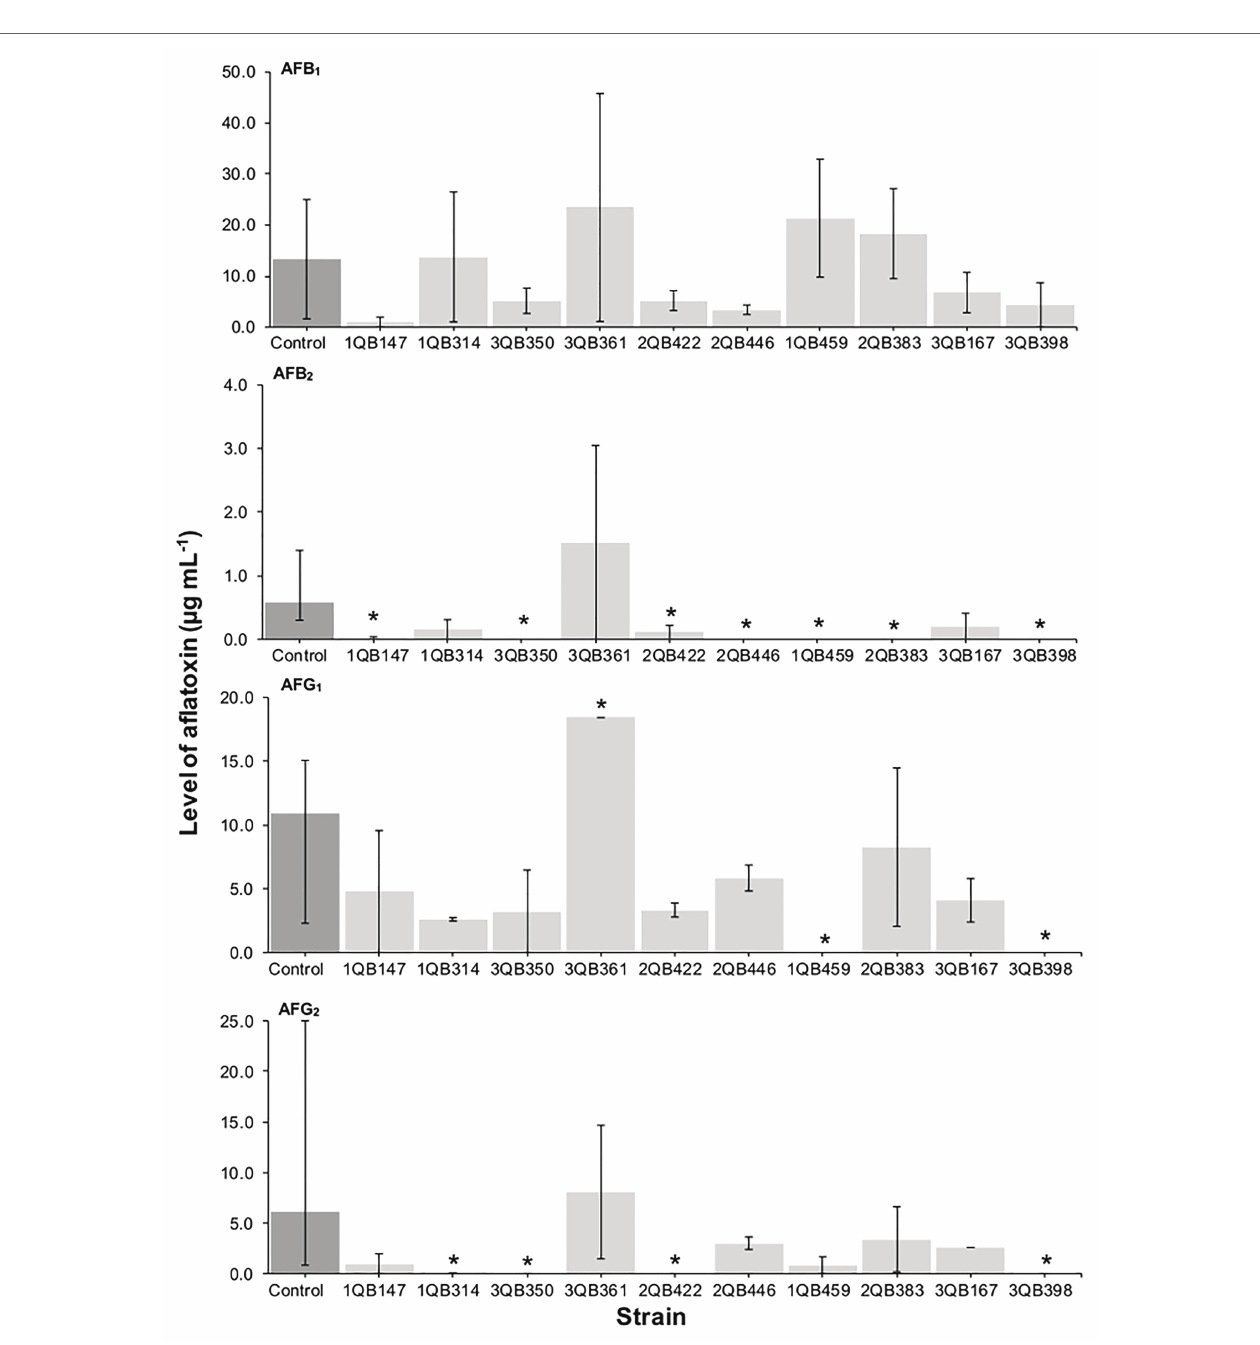
FIGURE 3 | Effect of LAB on production of AFB 1 , AFB 2 , AFG 1 , and AFG 2 by A. parasiticus NRRL 2999 in co-cultured YES broth after 7 days of incubation at 25 ° C. LAB was inoculated (5 log 10 cfu ml −1 ) after 24 h (Inoculation = T 24 h) incubation of the fungus. The individually tested LAB included: four strains of Lactiplantibacillus plantarum (former Lactobacillus plantarum , comprising strains 1QB147, 1QB314, 3QB350, and QB361), two strains of Levilactobacillus brevis (former Lactobacillus brevis , comprising strains 2QB422 and 3QB446), and four strains of Levilactobacillus spp. (former Lactobacillus sp., comprising strains 1QB4593, 2QB383, 3QB167, and QB398). Results are expressed as median values of three independent experiments, with minimum and maximum values indicated as error bars. *Median values with asterisks differ significantly from controls ( p <